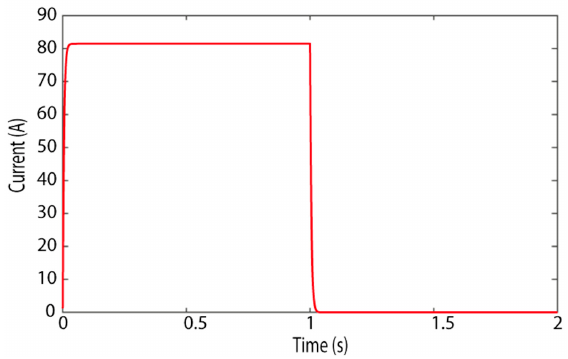
Figure 16. Current through CB5 during three-phase fault.